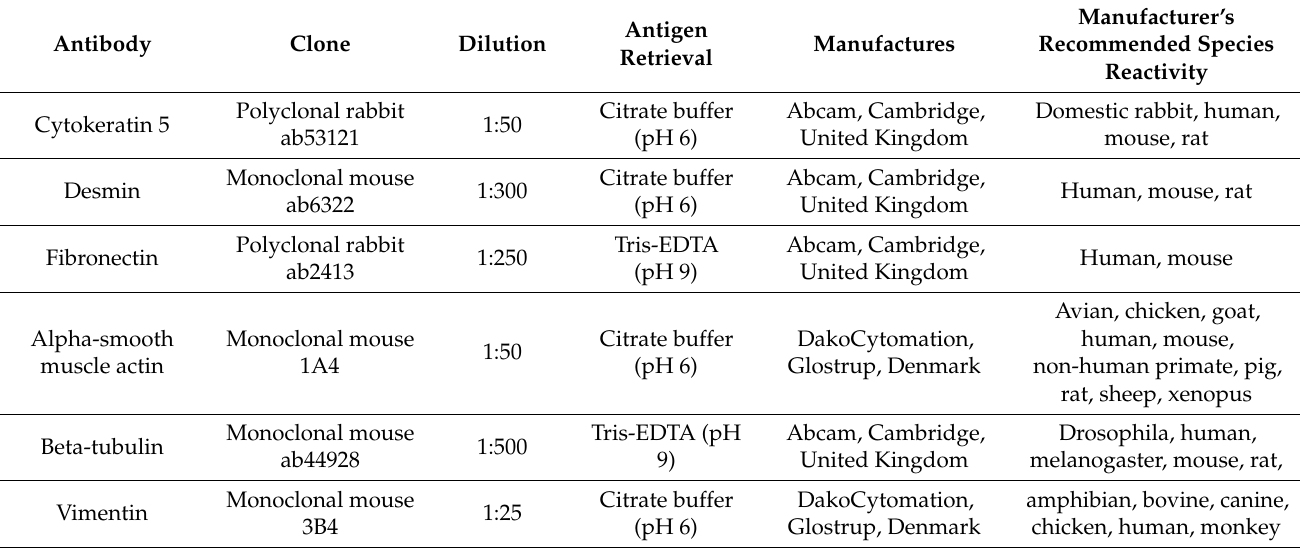
Table 1. Antibodies used for immunohistochemistry in this study.